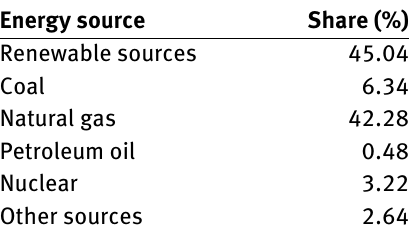
Table 3: Italian generation mix, reference year 2020 [32] Energy